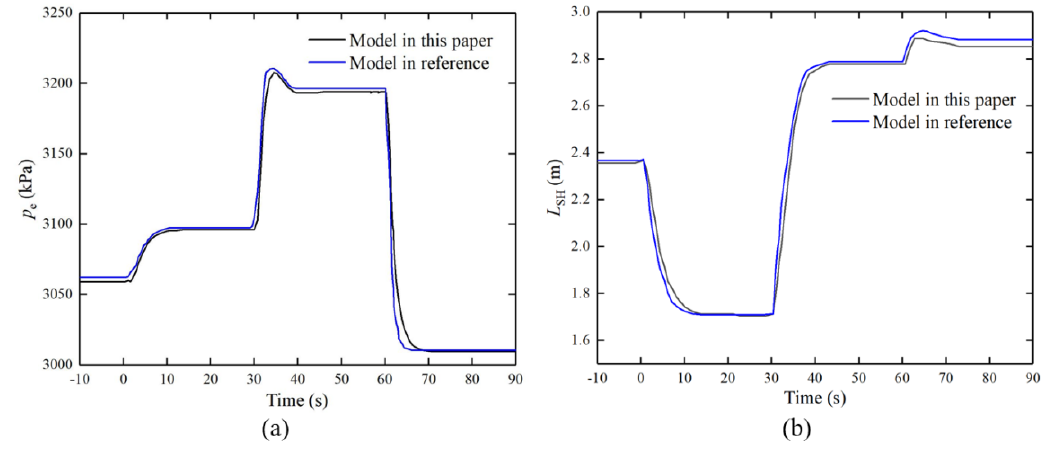
Figure 6. Model validation. ( a ) The evaporating pressure. ( b ) The length of the superheated region.